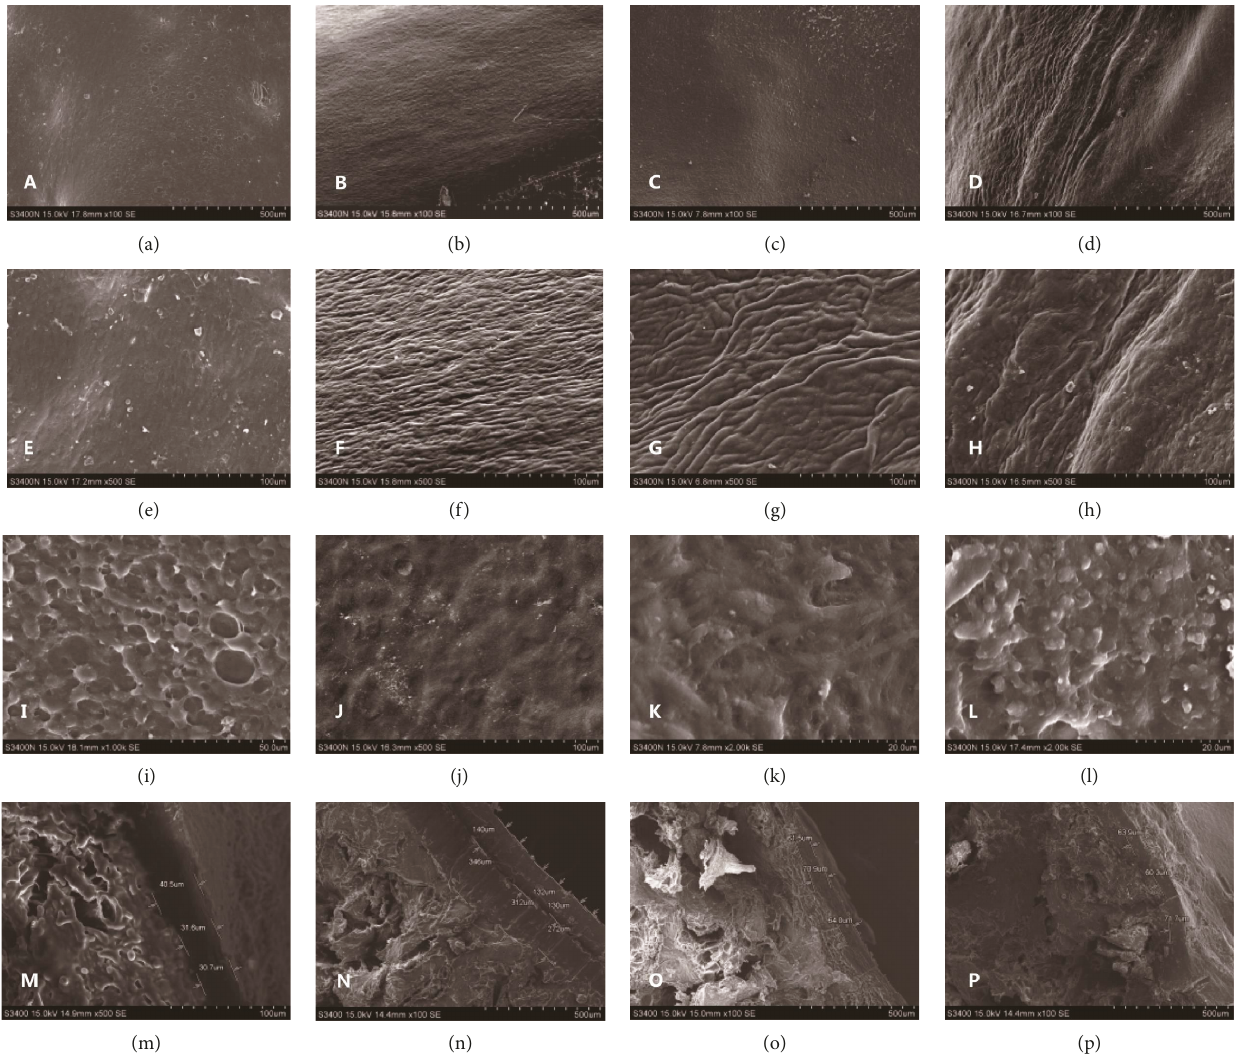
Figure 7: The canine knee cartilage images by SEM: (a) cross section of the untreated control group ( × 100 SE), (b) cross section of the normal control group ( × 100 SE), (c) cross section of the central neogenetic cartilage in the treated group ( × 100 SE), (d) cross section of the surrounding neogenetic cartilage in the treated group ( × 100 SE), (e) cross section of the untreated control group ( × 500 SE), (f) cross section of the normal control group ( × 500 SE), (g) cross section of the central neogenetic cartilage in the treated group ( × 500 SE), (h) cross section of the surrounding neogenetic cartilage in the treated group ( × 500 SE), (i) cross section of the untreated control group ( × 1000 SE), (j) cross section of the normal control group ( × 500 SE), (k) cross section of the central neogenetic cartilage in the treated group ( × 2000 SE), (l) cross section of the surrounding neogenetic cartilage in the treated group ( × 2000 SE), (m) vertical section of the untreated control group ( × 100 SE), (n) vertical section of the normal control group ( × 100 SE), (o) vertical section of the treated group a ( × 100 SE), and (p) vertical section of the treated group b ( × 100 SE). Table 2: The thickness of newborn cartilage in the OA model (mean ± SD, n = 3